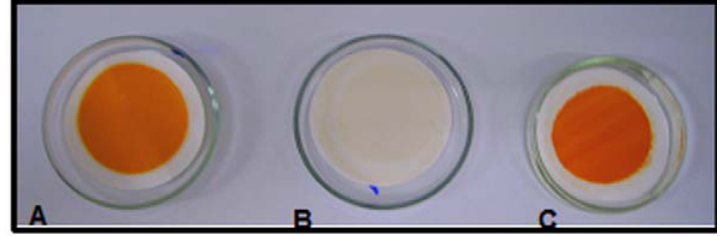
Figure 6. Residual complex formed of Orange II adsorped to albumin using vacuum filtration [Assay 16]. A = residue on cellulose acetate membrane obtained from maximum removal of azo dye/albumin 0.10 g/L (1:3 v/v) at 90 min of incubation, pH 3.0; B = Filtrate of azo dye (0.10 g/L)/water on cellulose acetate membrane; C = Filtrate obtained from azo dye 0.10 g/L cellulose acetate membrane.